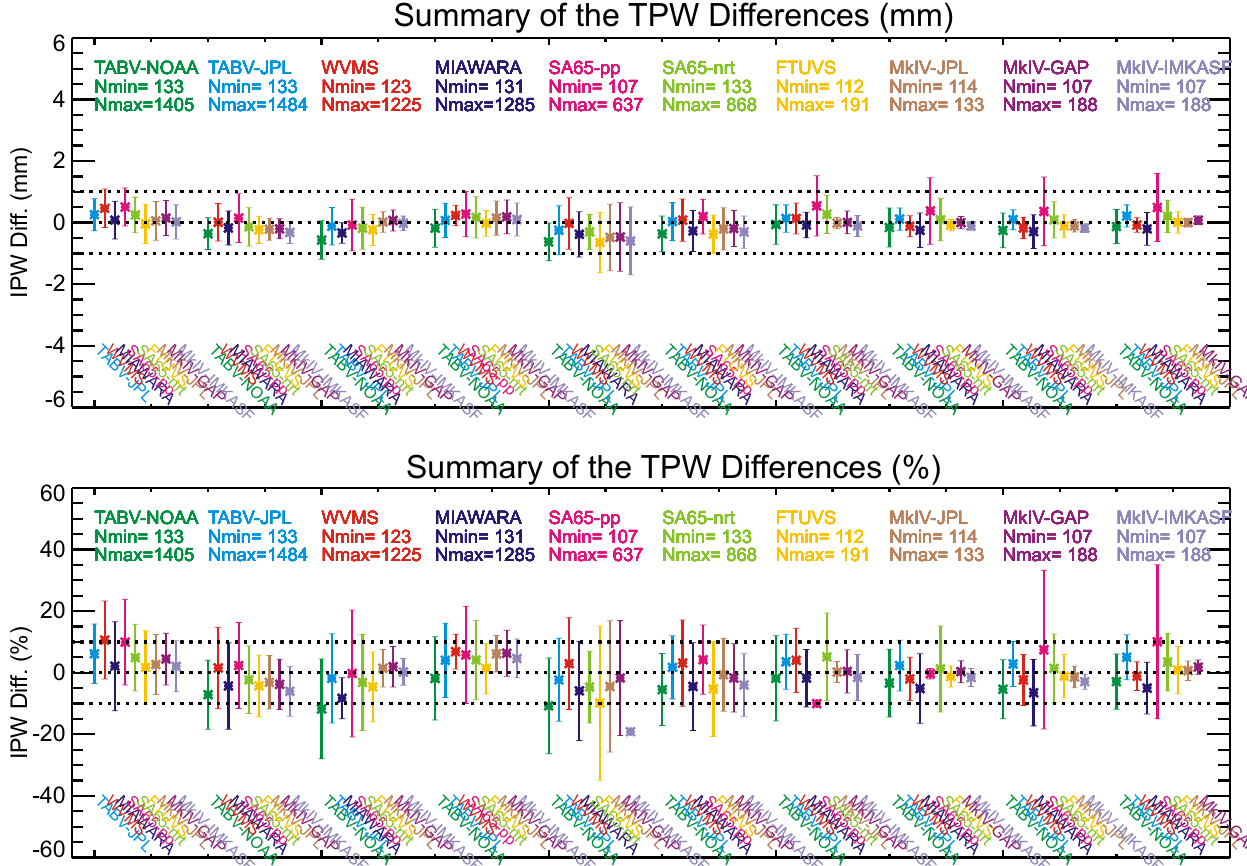
Fig. 15. Cross-comparison of all the TPW datasets available during MOHAVE-2009. The symbols indicate the difference between the dataset listed in the upper part of each plot (where the min and max number of coincidences are listed) and those listed in the lower part. The vertical bars indicate the spread of these differences See text for details. Use the colors for a better identification of the datasets: dark green=TABV- NOAA solution, cyan=TABV-JPL solution, red=WVMS, navy=MIAWARA-C, pink=SuomiNet-PP solution, light green=SuomiNet NRT solution, yellow=FTUVS, brown=MkIV-JPL solution, purple=MkIV-GAP solution, and blue=MkIV-IMKASF